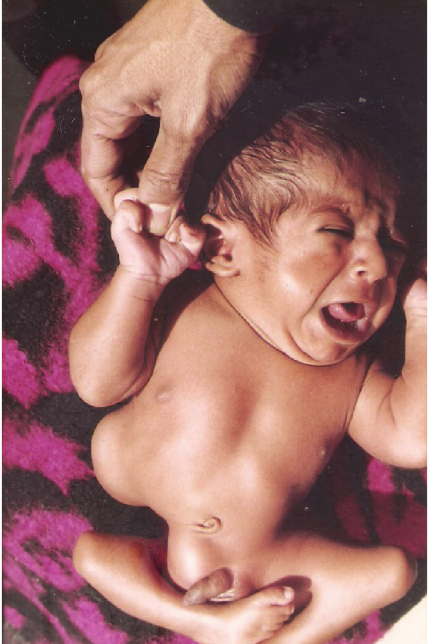
Figure 1: Right congenital lumbar hernia with severe musculoskele- tal deformity and right inguinal hernia.